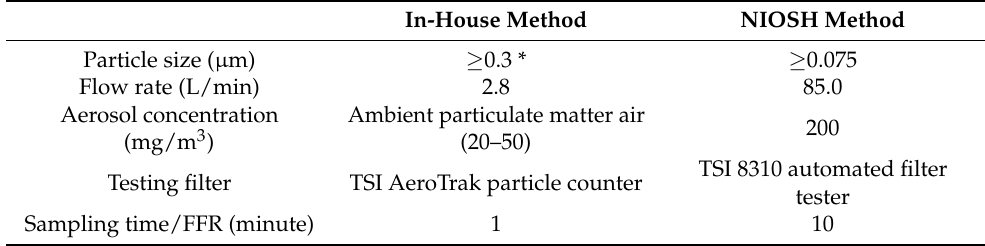
Table 2. Comparison between in-house and NIOSH filtration assessment